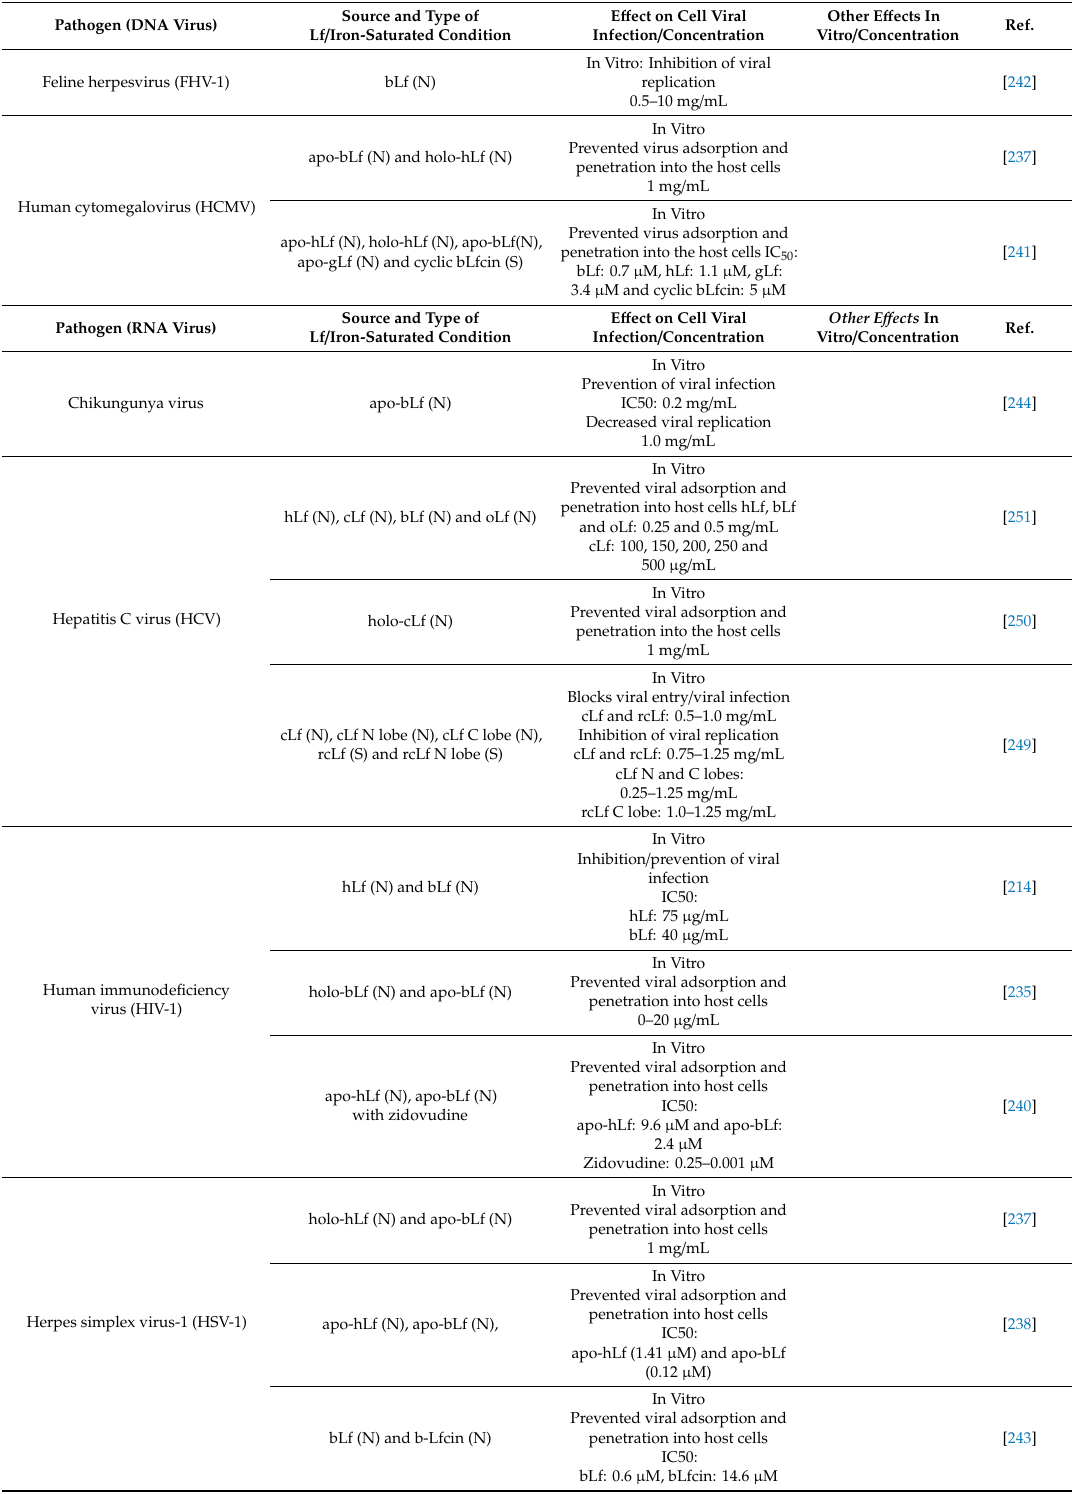
Table 4. E ff ects of lactoferrin and lactoferricins on pathogenic viruses. Pathogen (DNA